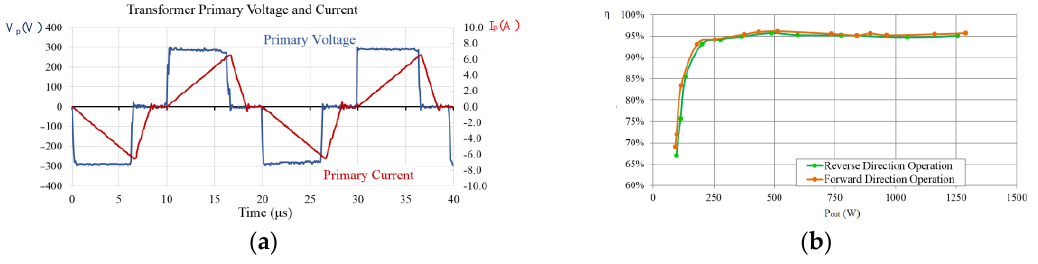
Figure 11. Bi-directional Operation Experiment ( a ) Transformer Primary Voltage and Current of Reverse Direction Operation; ( b ) Efficiency comparison.